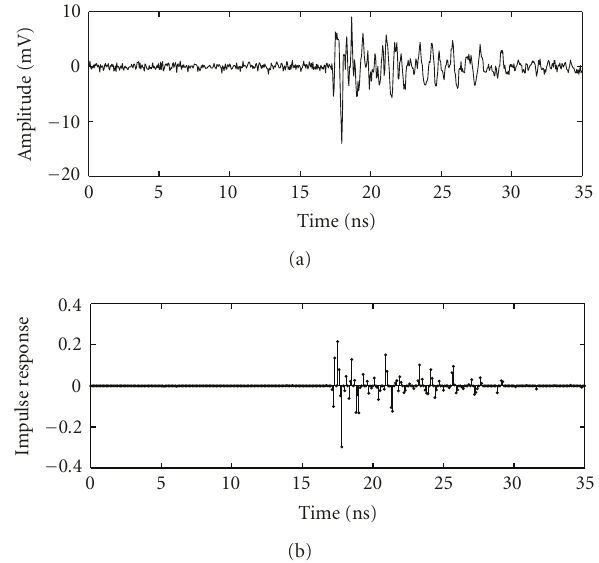
Figure 8: Example of received waveform and the corresponding CIR for engine compartment